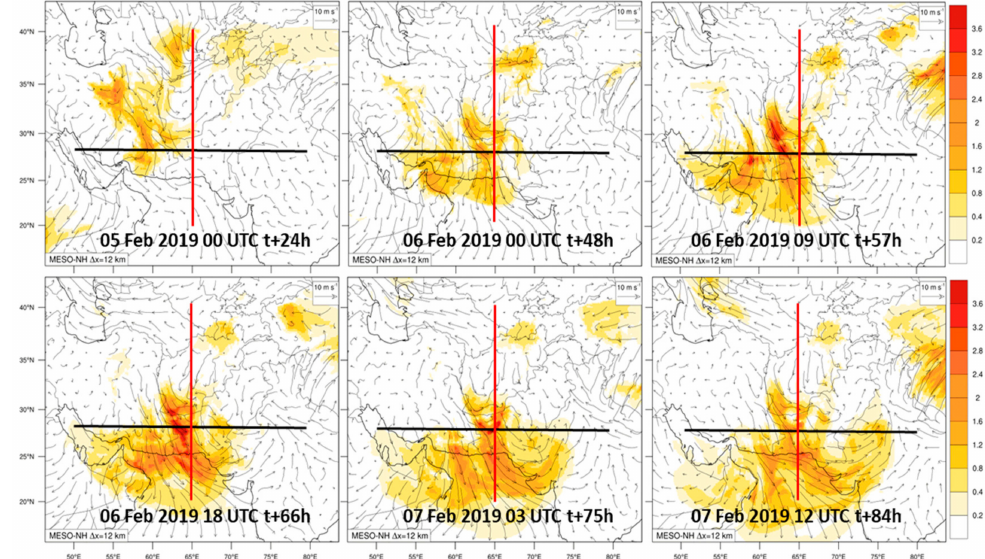
Figure 8. Spatial distribution of the dust AOD simulated by the Meso-NH model for certain hours during 5–7 February 2019 over southwest